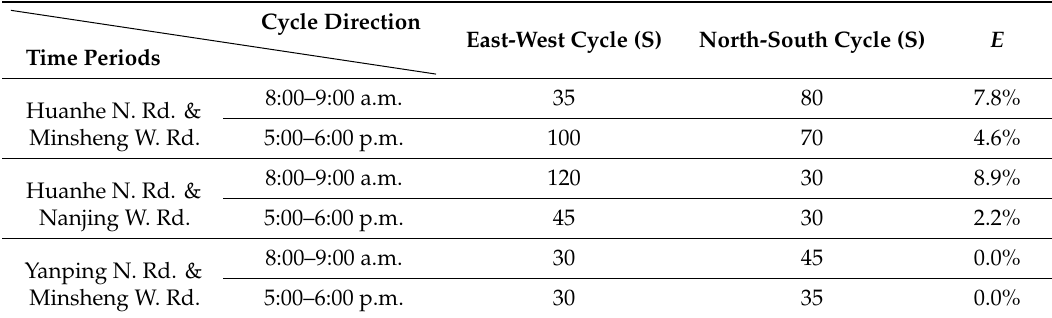
Table 3. The optimal cycle configuration time for each